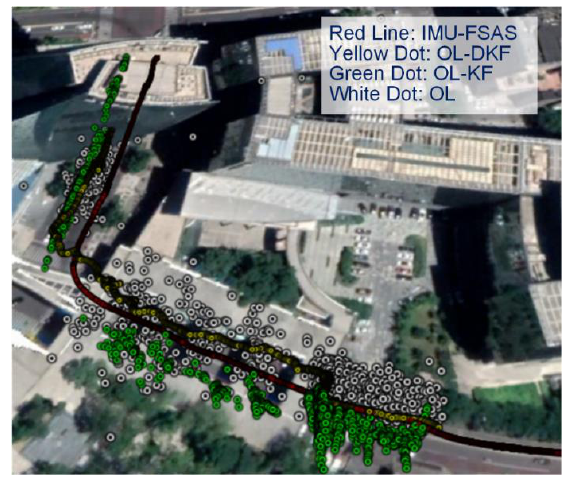
Figure 27. Satellite visibility of roads in the city canyon test.